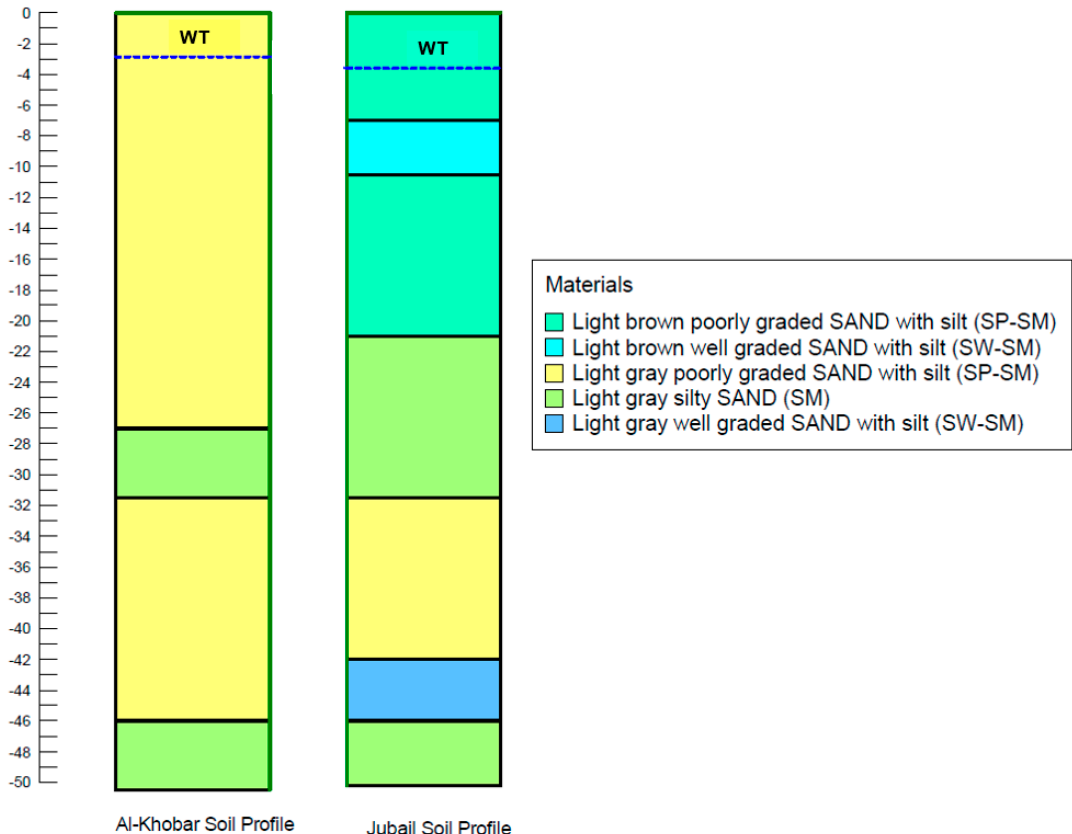
Figure 7. Soil profiles for the Al-Khobar and Jubail sites.